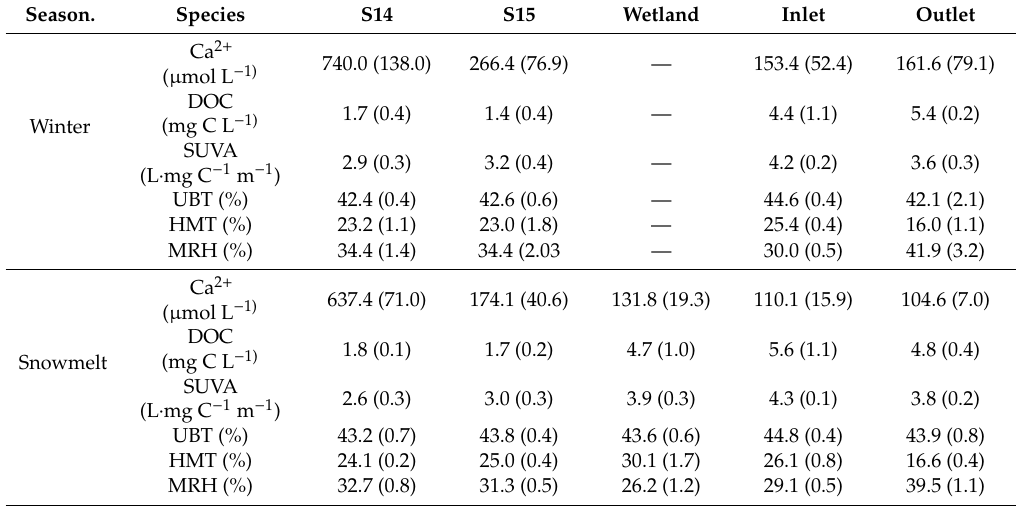
Table A1. Average seasonal (standard deviation) values for surface water chemistry and carbon quality at the Arbutus Lake